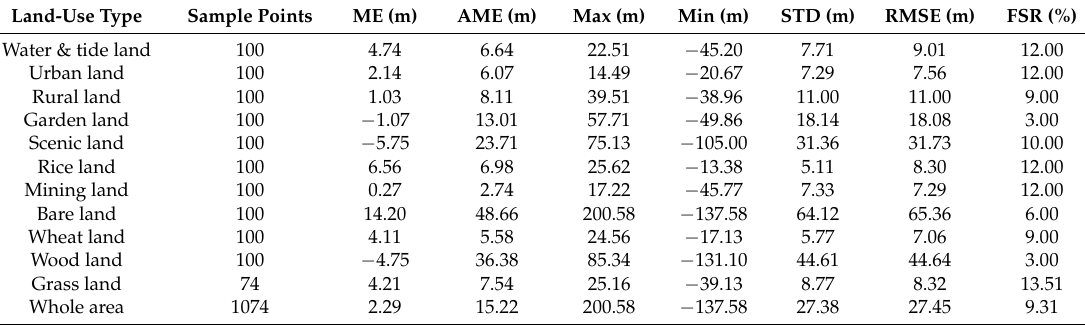
Table 7. Statistical measures of the difference between original GDEM2 and GNSS measurements by using the second sample set for